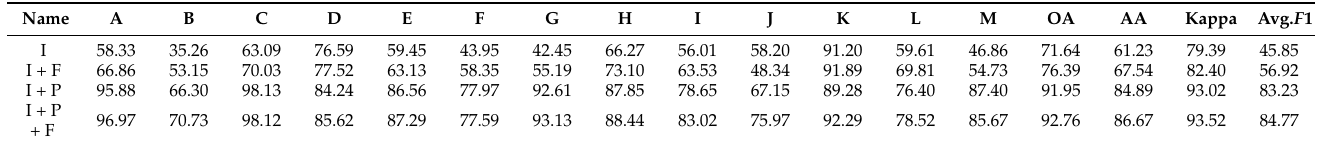
Table 3. Overall classification results and per category results for Area_2. (I: image, F: building footprint, P: points of